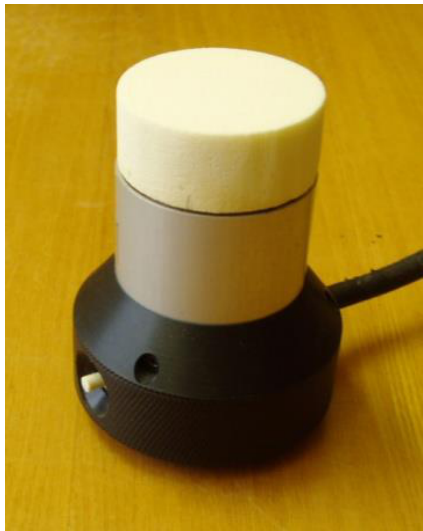
Figure 1. OSA sensor and a PUR foams’ sample.